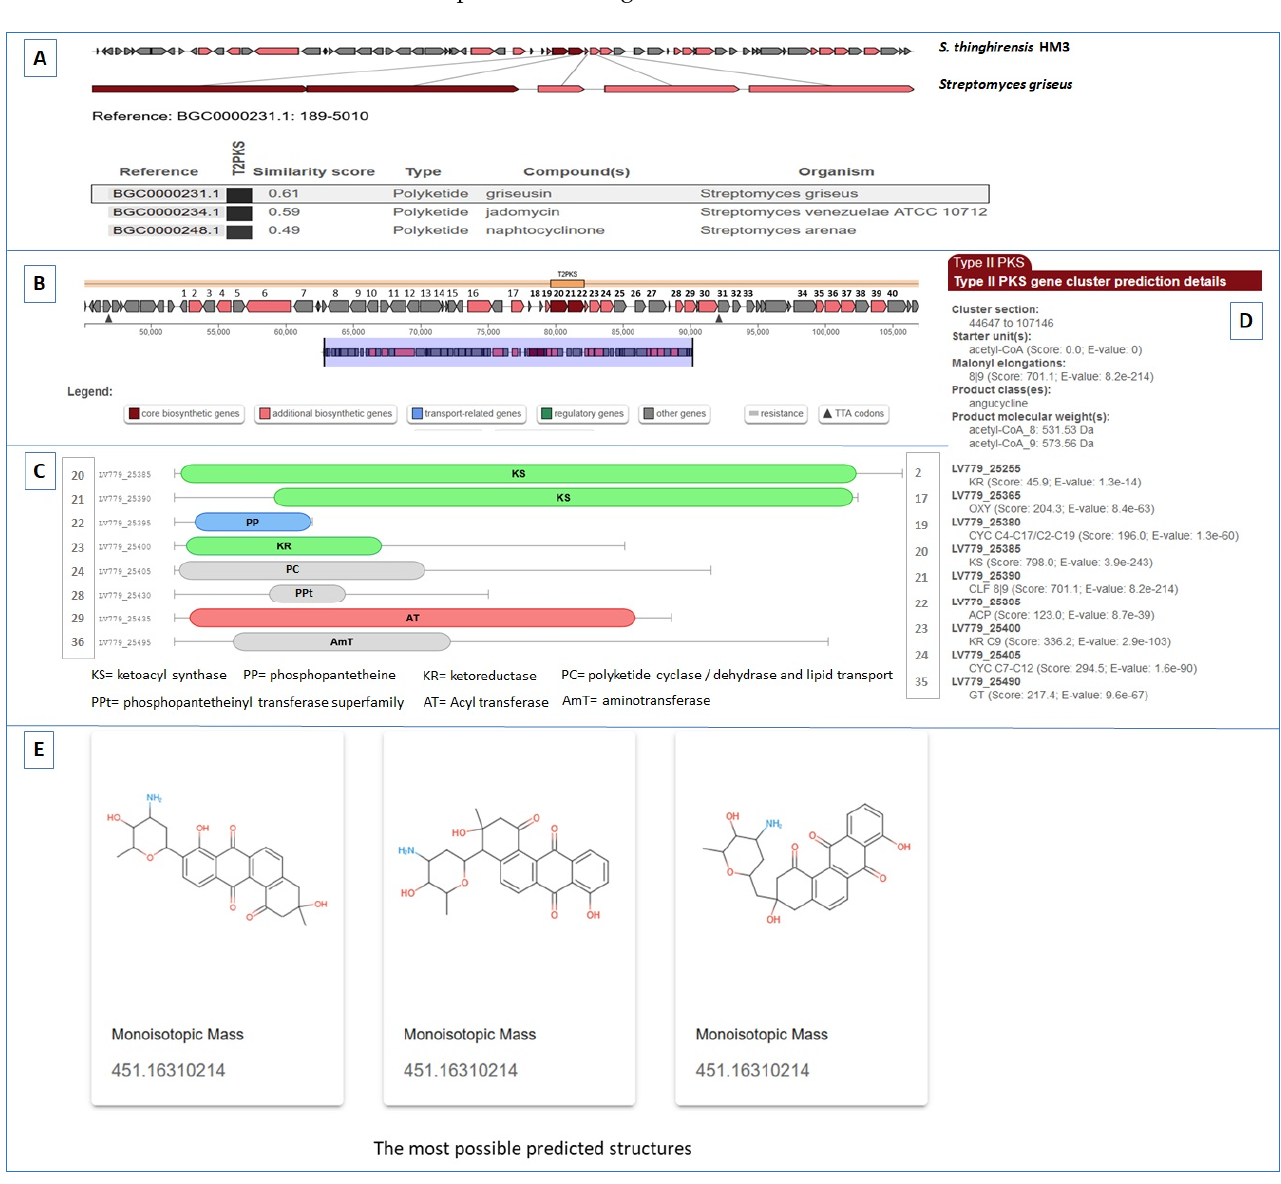
Figure 7. Type II PKS biosynthetic gene cluster in S. thinghirensis HM3. ( A ) The MIBiG comparison between the proposed Type II PKS BGC in strain HM3 and the proposed identified cluster of griseusin and jadomycin in S. griseus and S. venezuelae ATCC 10712, with a similarity score reaching 0.61 and 0.59. ( B ) The proposed type II PKS BGC in region 44.1 of strain HM3 genome. ( C , D ) represent the domains involved in PKS biosynthesis. ( E ) represents the most possible predicted chemical structures based on PRISM.